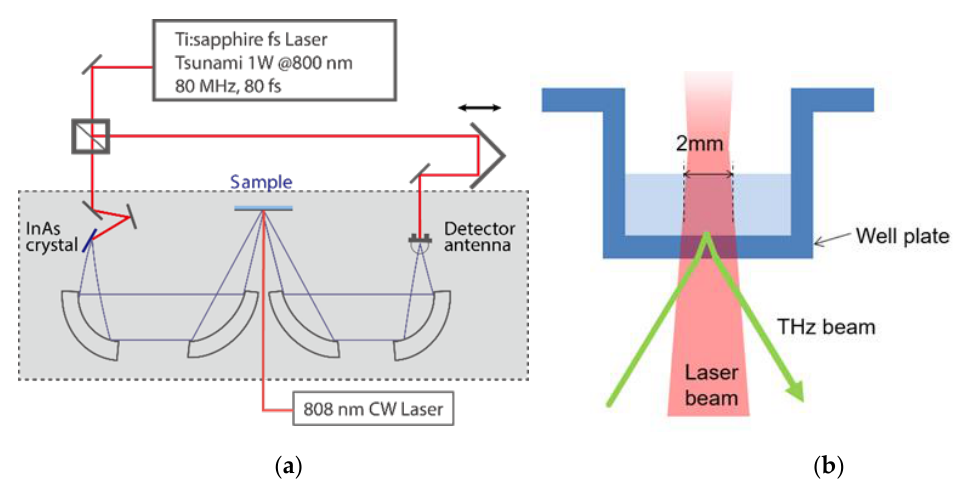
Figure 1. ( a ) Terahertz (THz) thermal spectroscopy and ( b ) a sample schematic.